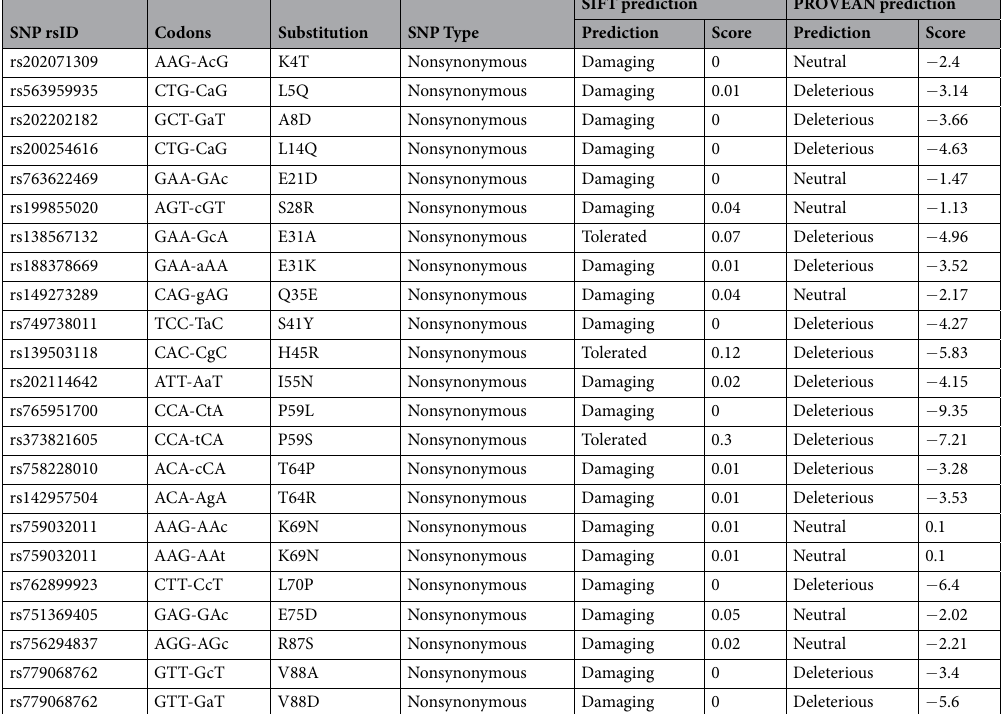
Table 2. Sequence homology-based prediction of damaging coding nsSNPs in IL8 gene using SIFT and